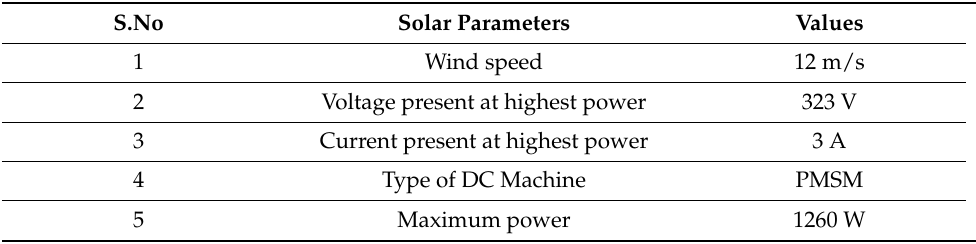
Table 2. Electrical parameters of the wind system. S.No Solar Parameters Values 1 Wind speed